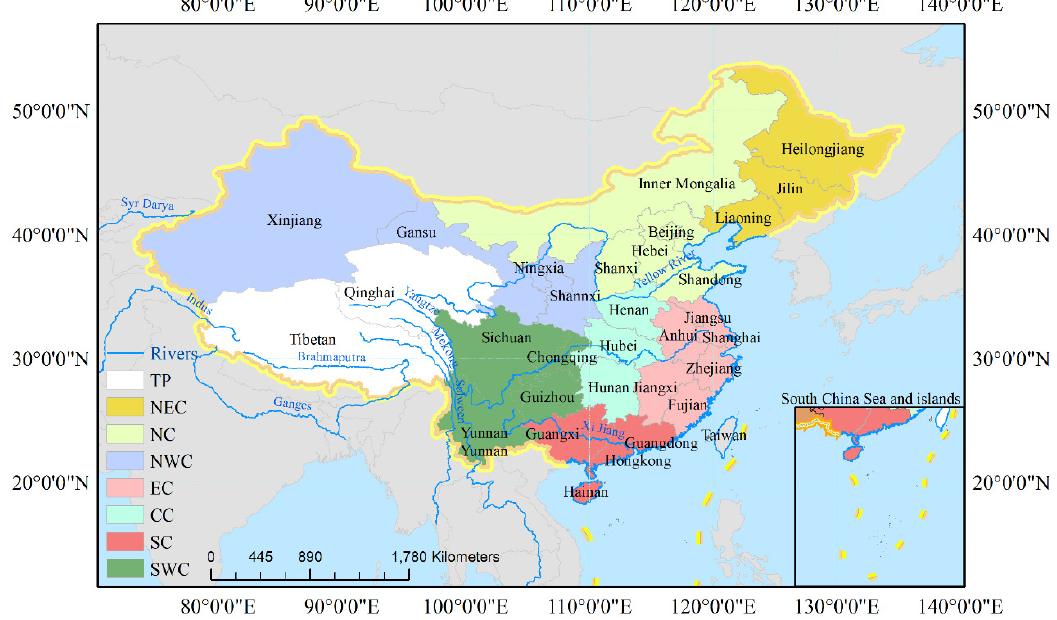
Figure 1. Location of the study area and its eight